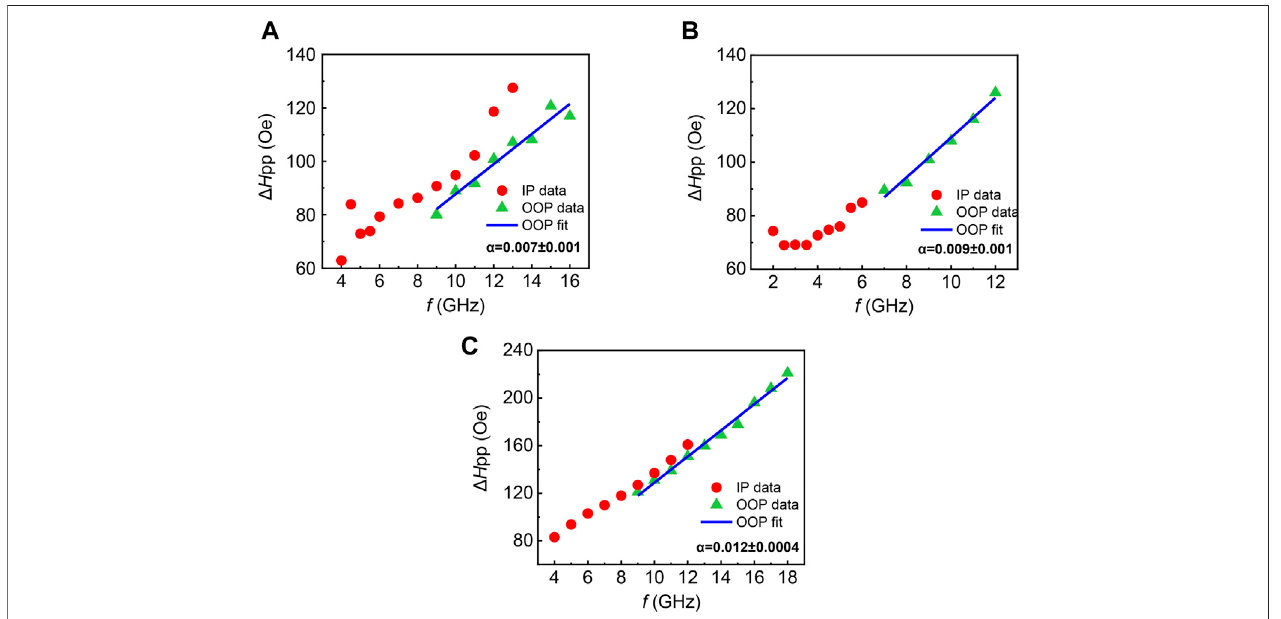
FIGURE 7 | Relationship between the frequency and the FMR linewidth in (A) 10-, (B) 20-, and (C) 30-nm-thick samples under in-plane and out-of-plane magnetized condition. The Gilbert damping factor in each thickness fi lm and its error bar are shown in the fi gure, respectively.